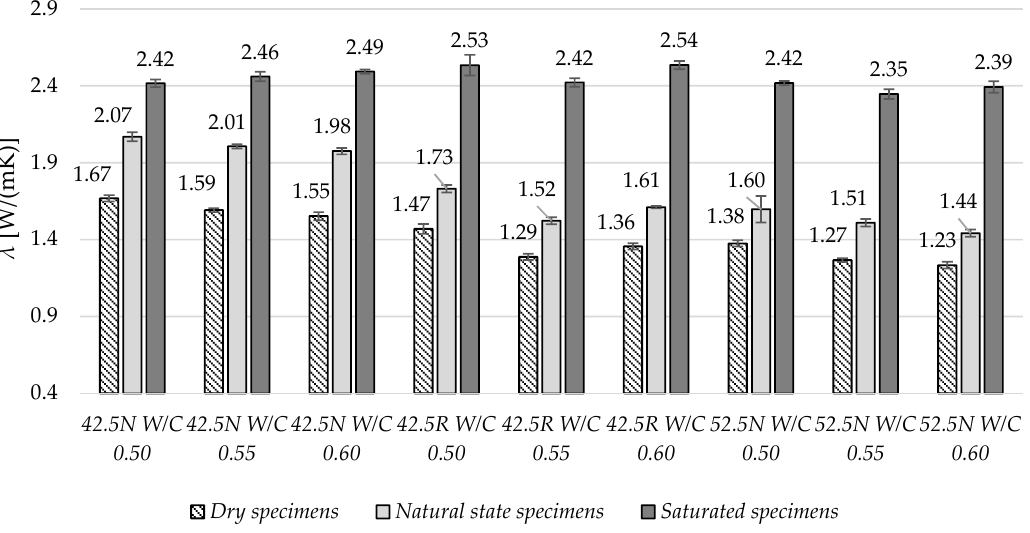
Figure 5. The average thermal conductivity values in three moisture states.